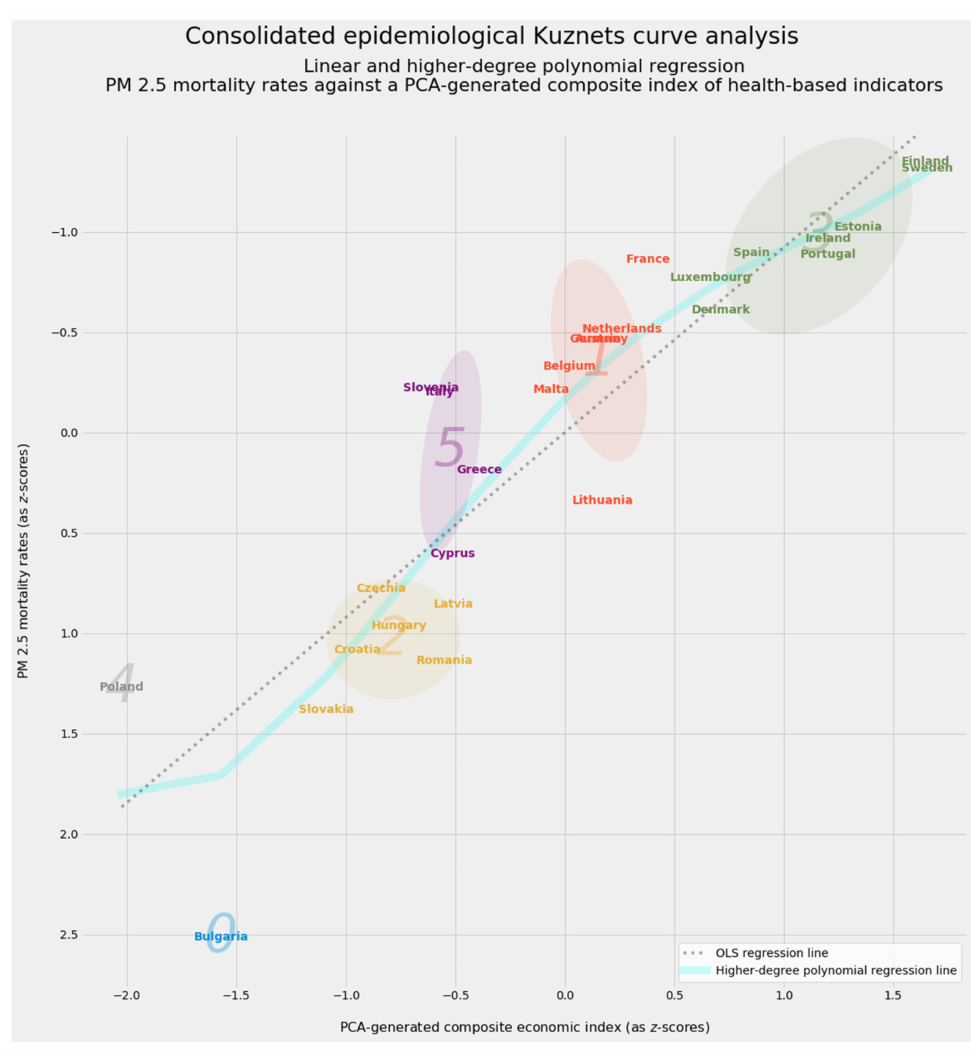
Figure 17. The environmental Kuznets curve for the PCA-generated composite health-based